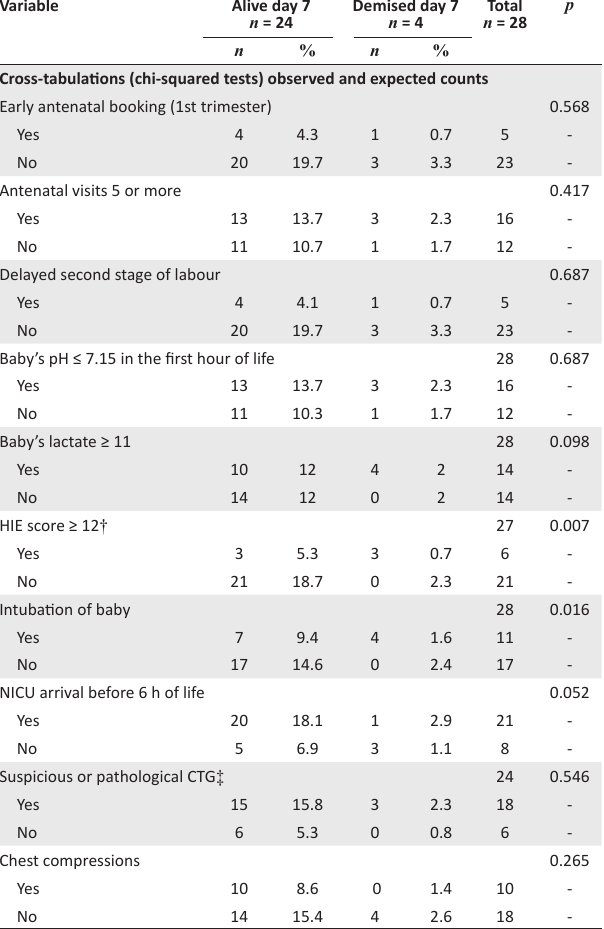
TABLE 5b: Associations between variables and outcomes (abnormal amplitude electroencephalograms and mortality) represented by cross-tabulations and chi-square tests.